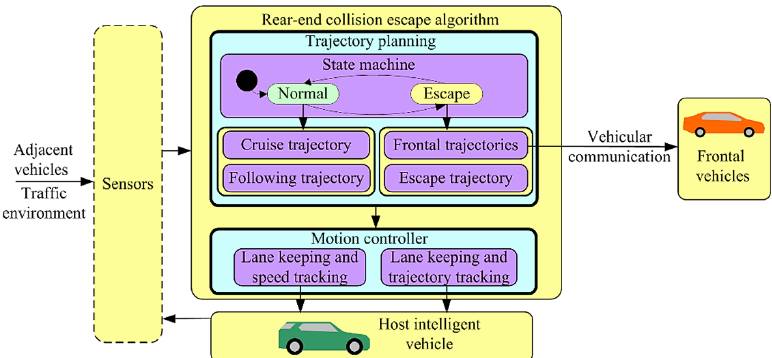
Figure 1. Structure of a rear-end collision escape algorithm (source: created by the authors)